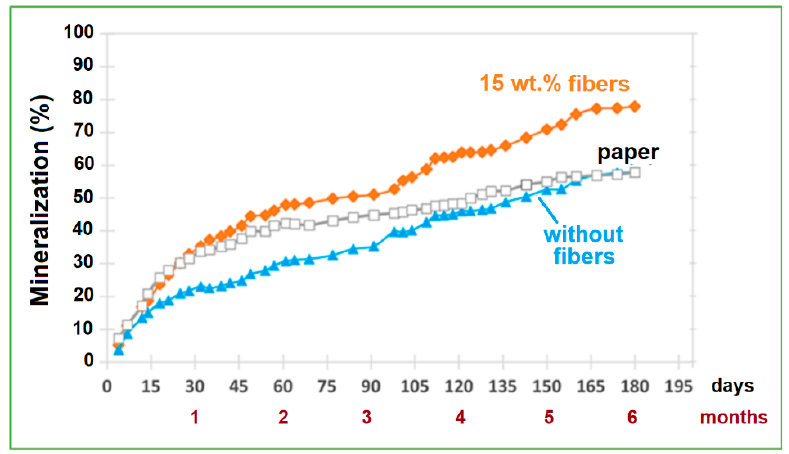
Figure 4. Mineralization curves under simulated terrestrial environmental conditions.